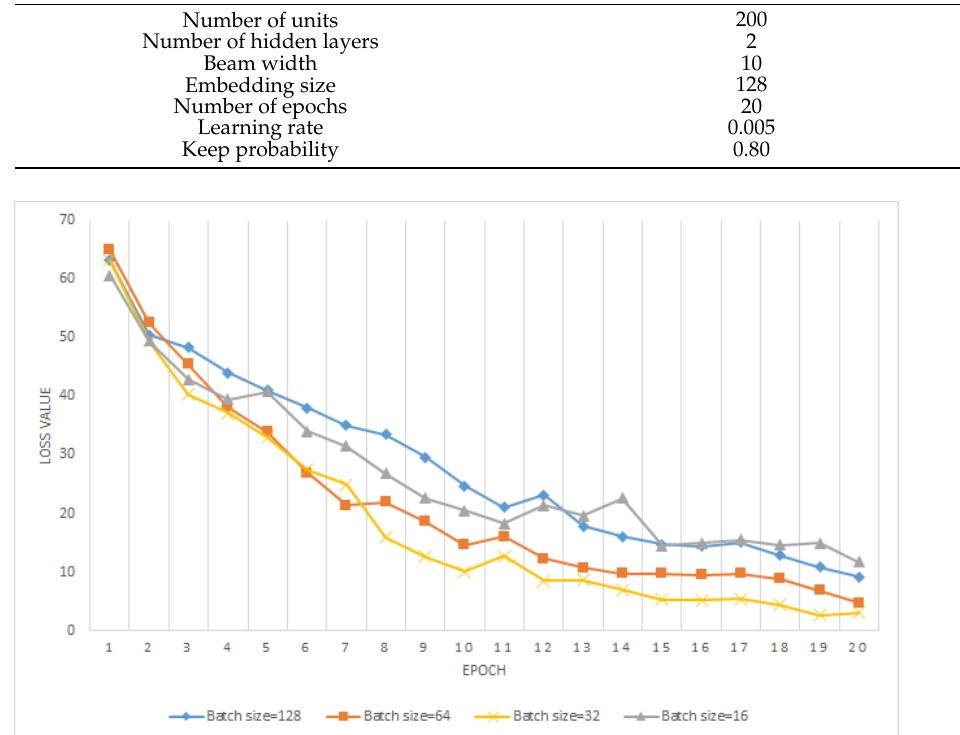
Figure 2. Sensitivity analysis results for batch size on the testing